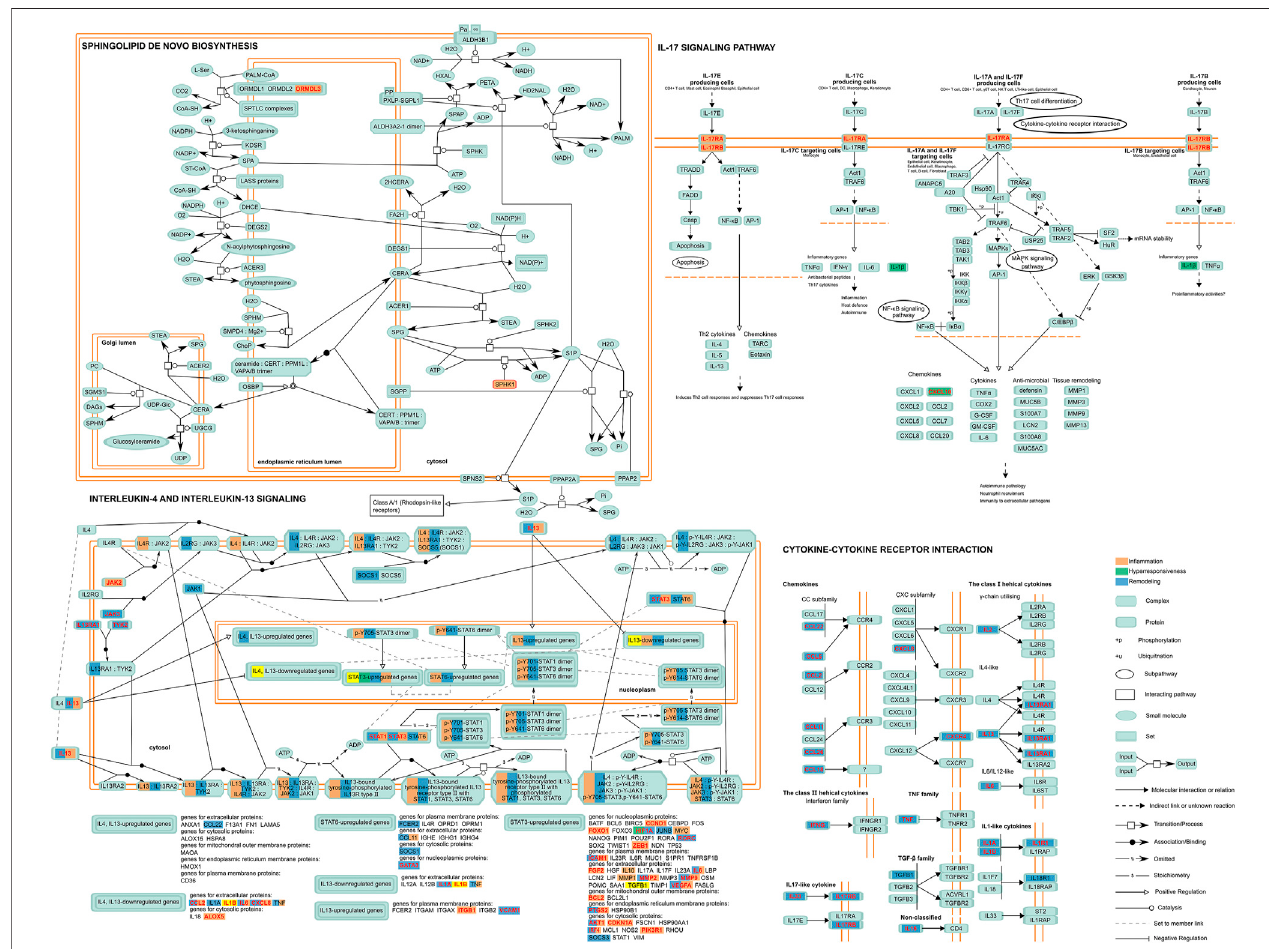
FIGURE 4 | A depiction of the disease features of the ceRNA network-involved pathway. Proteins encoded by risk genes concerning in fl ammation, hyperresponsiveness, and remodeling and related complexes are indicated in orange, green, and blue respectively, while those in red character represented encoding genes indicate the ceRNA regulation-containing genes with regulatory SNPs. Yellow represents the signi fi cant elements related to all disease features in a pathway.